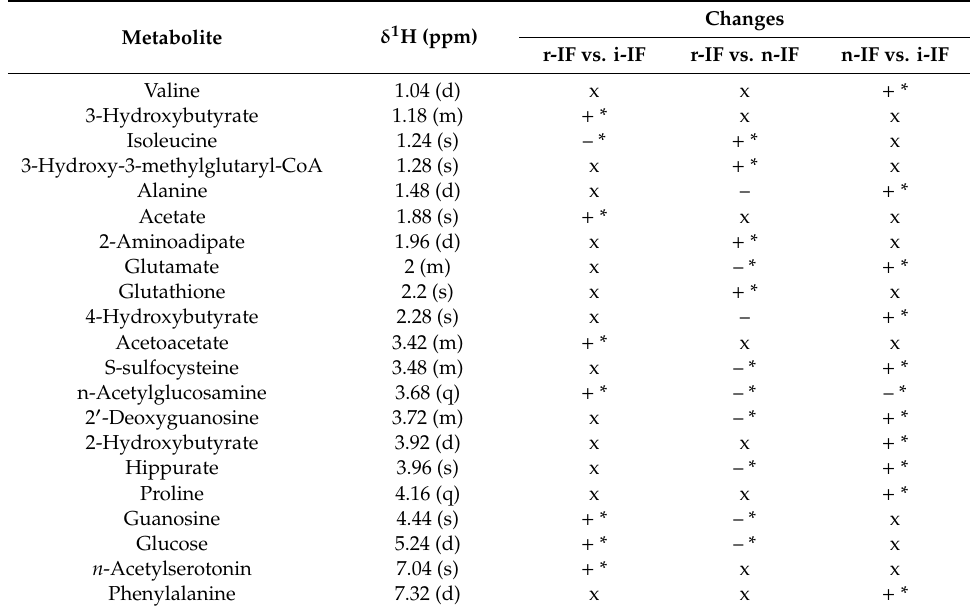
Table 4. Changes in plasma metabolites of mild cognitive impairment (MCI)-a ffl icted older adults in relation to fasting status.